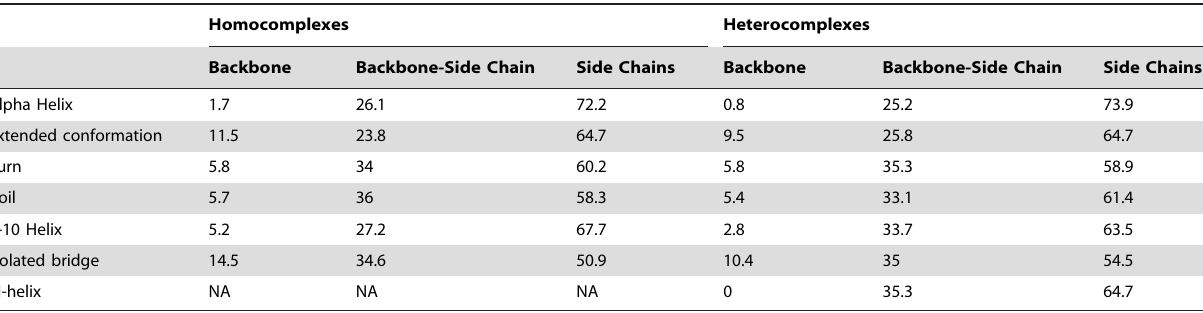
Table 3. Percentage of atomic contacts per type of structural element.